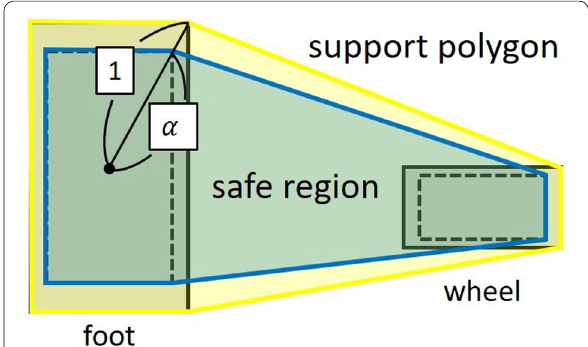
Fig. 8 Support polygon and safe